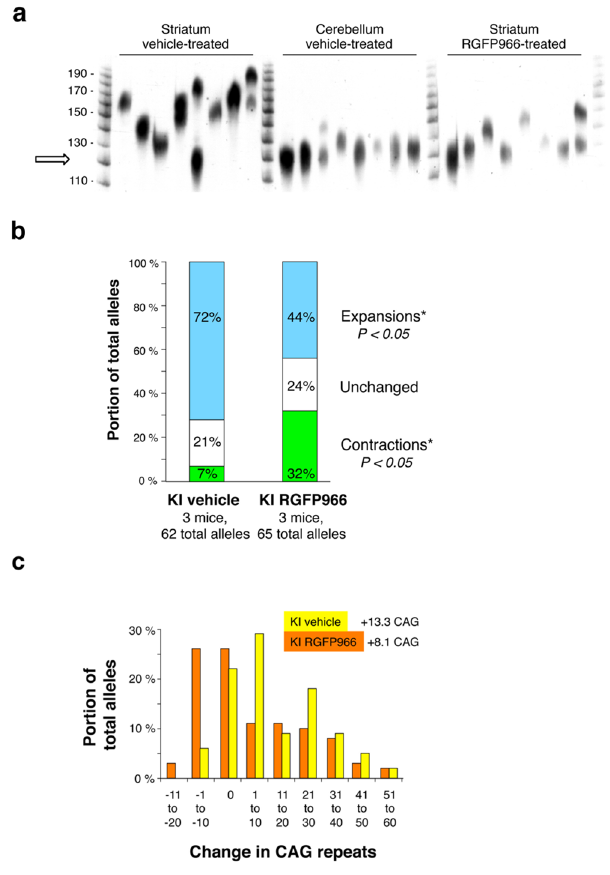
Figure 6. RGFP966 suppresses striatal CAG repeat expansions. (a) Representative display of small-pool PCR of somatic repeat lengths from single Hdh Q7/Q111 (KI) animals, either chronically treated with vehicle or with RGFP966. Size markers correspond to CAG repeat number. The examples shown represent the positive signals from one analysis. Arrow indicates size of initial CAG tract. This image has been cropped; the original is provided in Supplementary Figure 4. ( b ) Summary of genetic changes. For each group, n = 3 mice, 62–65 independent events. Starting tract sizes, estimated from the most common allele size in cerebellum and stated as repeat units, were 110–119, 120–129 and 120–129 for vehicle-treated mice; and 120–129, 120–129 and 130–139 for RGFP966-treated mice. * p < 0.05 by Student’s t-test. (c) Histogram of expansion sizes from the alleles tested in b . Allele sizes were binned into 10-repeat size groups, e.g . falling between + 1 to + 10 repeats compared to the starting allele size. Starting tract lengths were deduced from the most common allele size in the cerebellum of the same